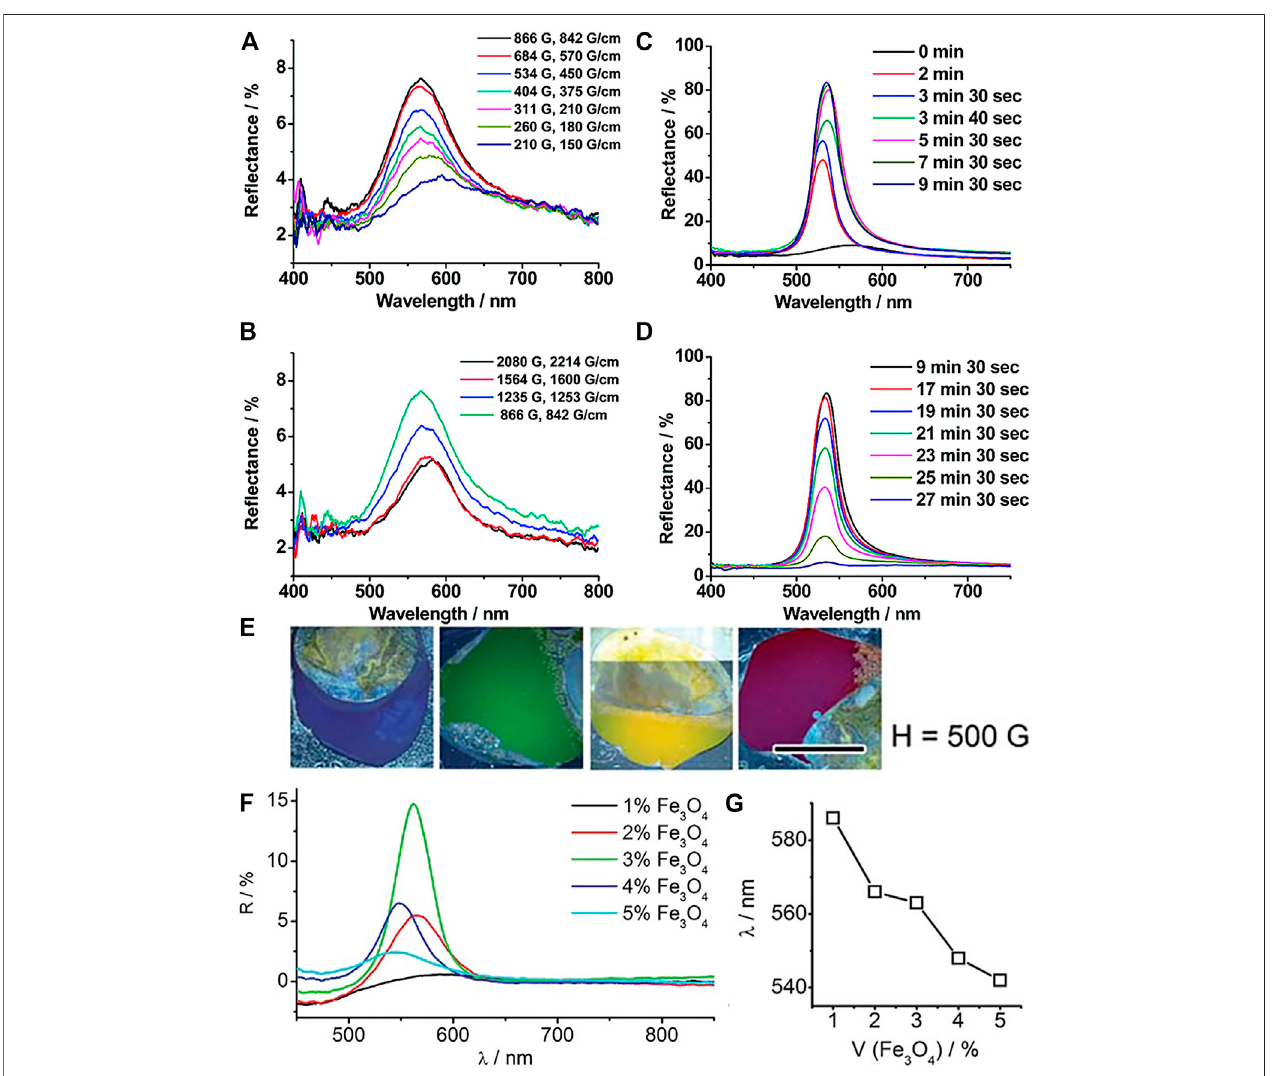
FIGURE 11 | (A , B) Re fl ection spectra of the 1 mm thick fi lm of mixed PS beads and ferro fl uid solution in response to an external MF with varying strengths. The volume fractions are 4% for both PS and Fe 3 O 4 ; (C , D) Time-dependent re fl ection spectra of the 1 mm thick liquid fi lm of mixed PS and ferro fl uid solution in response to anMFof2530 Gwithagradientof2500 G/cm.TheMFwasremovedat3 min30 s.Thevolumefractionsare4%forbothPSandFe 3 O 4 .Reprintedwithpermissionfrom Heetal.(2010).Copyright © 2010AmericanChemicalSociety. (E) ThebrownmixtureofthePScolloidsandtheferro fl